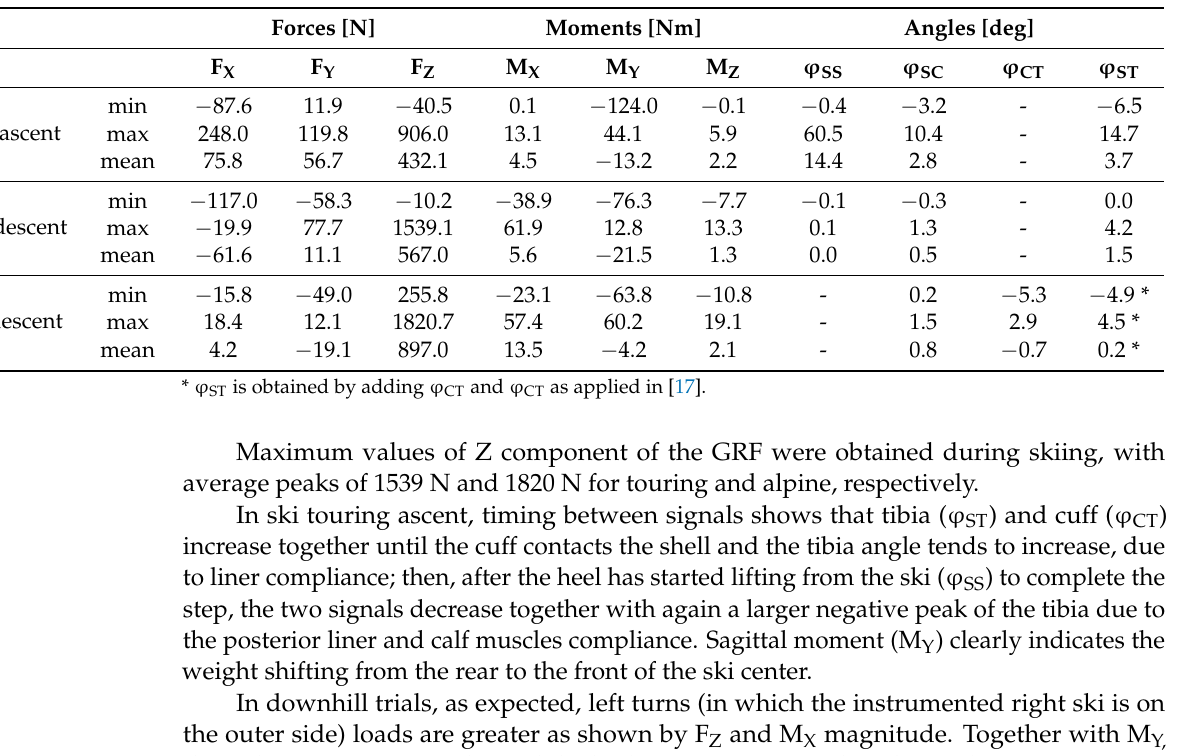
Figure 7. Ground reaction forces and kinematics during alpine ski session: ( a ) forces; ( b ) moments; ( c ) angles. Table 2. Min, max, and mean values obtained during the